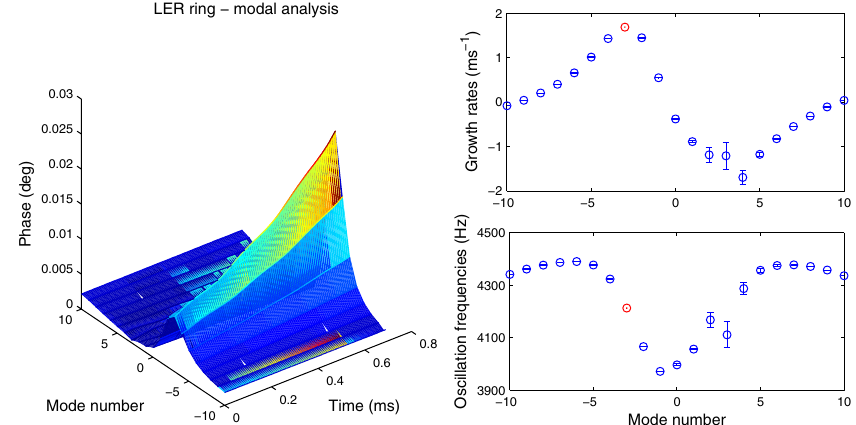
FIG. 5. (Color) Simulated low frequency beam modes (LER at 2500